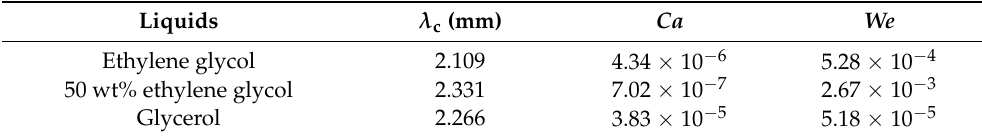
Table 2. Rheological properties of experimental